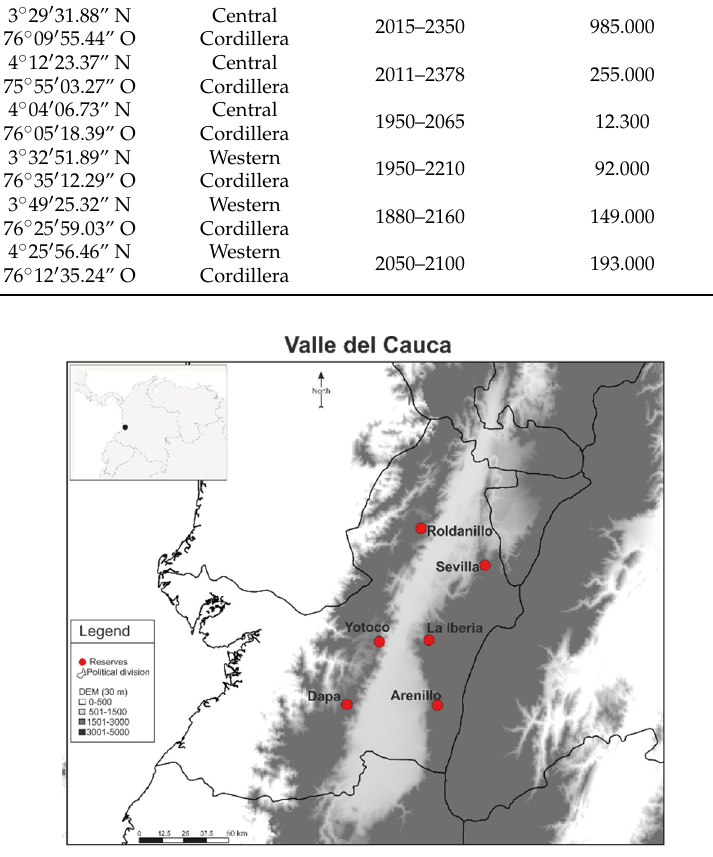
Figure 1. Study area in Valle del Cauca state, red dots represent the studied reserves.